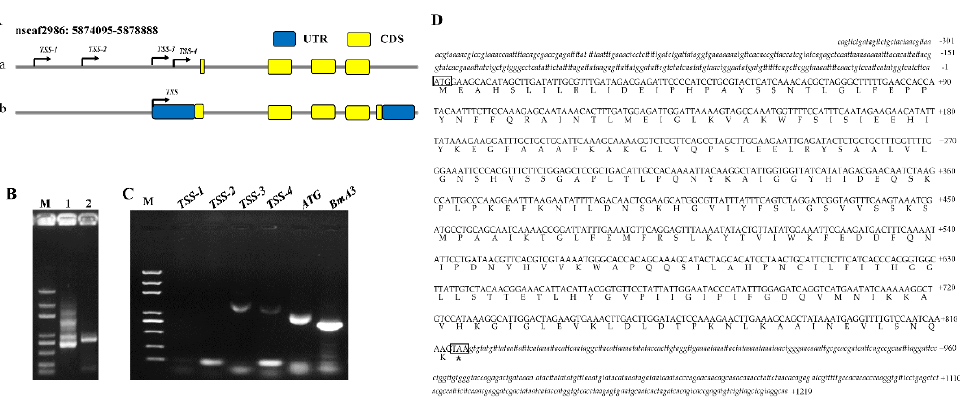
Figure 3. Obtaining the BmUGT10295 full-length cDNA. ( A ): The schematic phase included struc- tural information of BmUGT10295 in the genome. ( a ), Annotation information of BmUGT10295 in genome; TSS-1~TSS-4 represented the predicted transcription initiation site; ( b ), Schematic diagram of BmUGT10295 gene structural information corrected according to experimental results. The yellow squares represent coding DNA sequences (CDS), whereas the blue squares represent untranslated regions (UTR). ( B ): 3′ RACE of BmUGT10295 ; 1 is from the first round of PCR and 2 is from the nested PCR. ( C ): Determination of transcription start sites (TSSs). ( D ): The full-length cDNA sequence of BmUGT10295 .